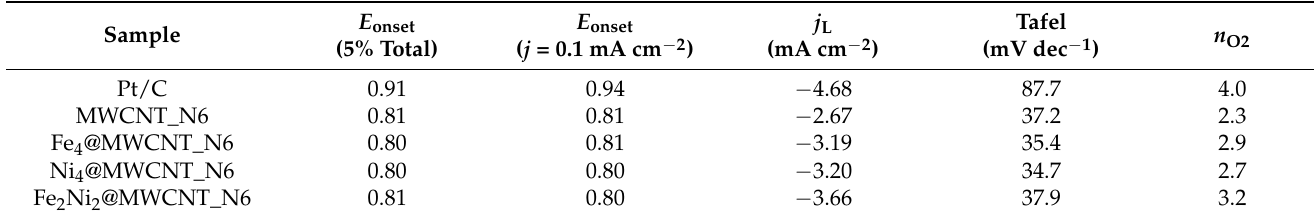
Table 3. The ORR performance parameters for all the materials